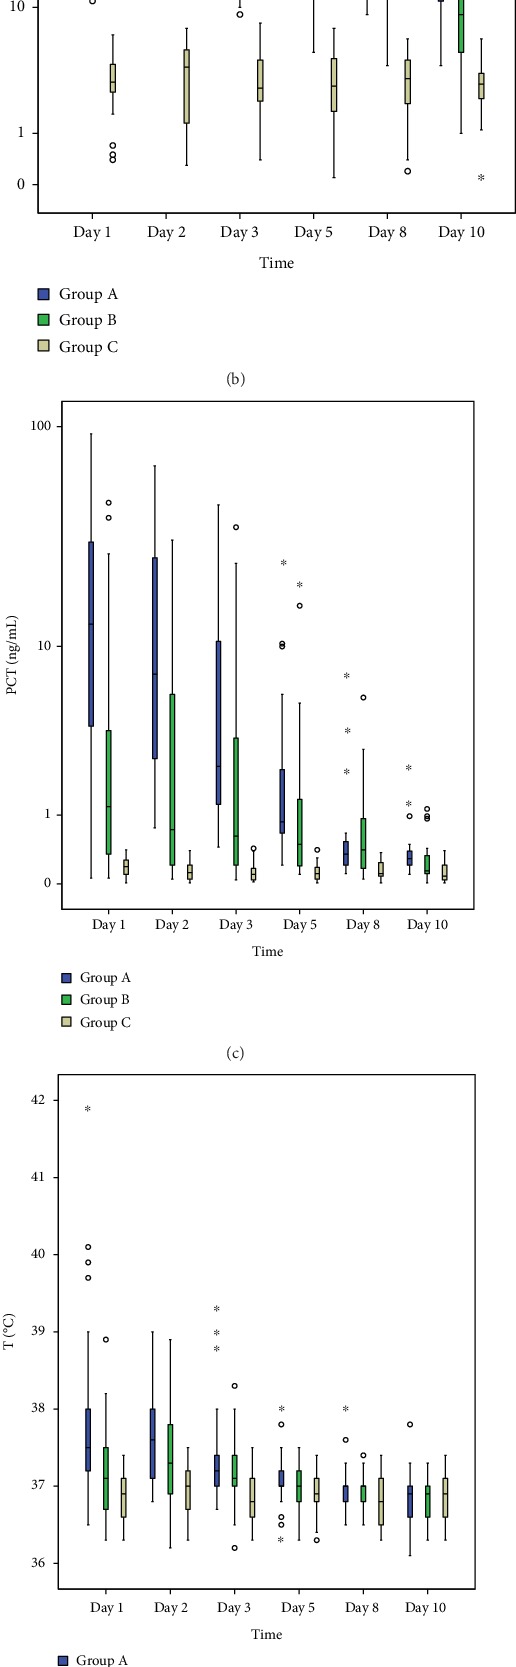
Dynamic monitoring of WBC, CRP, PCR, T, and sTREM-1 in three groups. WBC: white blood cell; CRP: C-reactive protein; PCT: procalcitonin; T: temperature; sTREM-1: soluble triggering receptor expressed on myeloid cells 1. Group A (blue), AC patients with sepsis; Group B (green), AC patients without sepsis; Group C (yellow), inpatients without AC or other infections. (a) The sTREM-1 levels among three groups had significant difference from day 1 to day 5. And both in Groups A and B, sTREM-1 levels declined fast between day 1 and day 2 (P < 0.05). (b) The WBC level in Group A was higher than that in Groups B and C from day 1 to day 5, and it was higher in Group B than in Group C. (c) CRP levels among three groups had significant difference for all days (P < 0.01), except CRP levels between Group A and Group B on day 1. (d) Group A had a significantly higher PCT level than Groups B and C in all days; and Group B's PCT level was higher than Group C's from day 1 to day 5. (e) On day 1 and day 3, Group A's T was higher than that of Groups B and C; on day 2, Group A and B's T was higher than Group C, while there was no difference between Groups A and B.